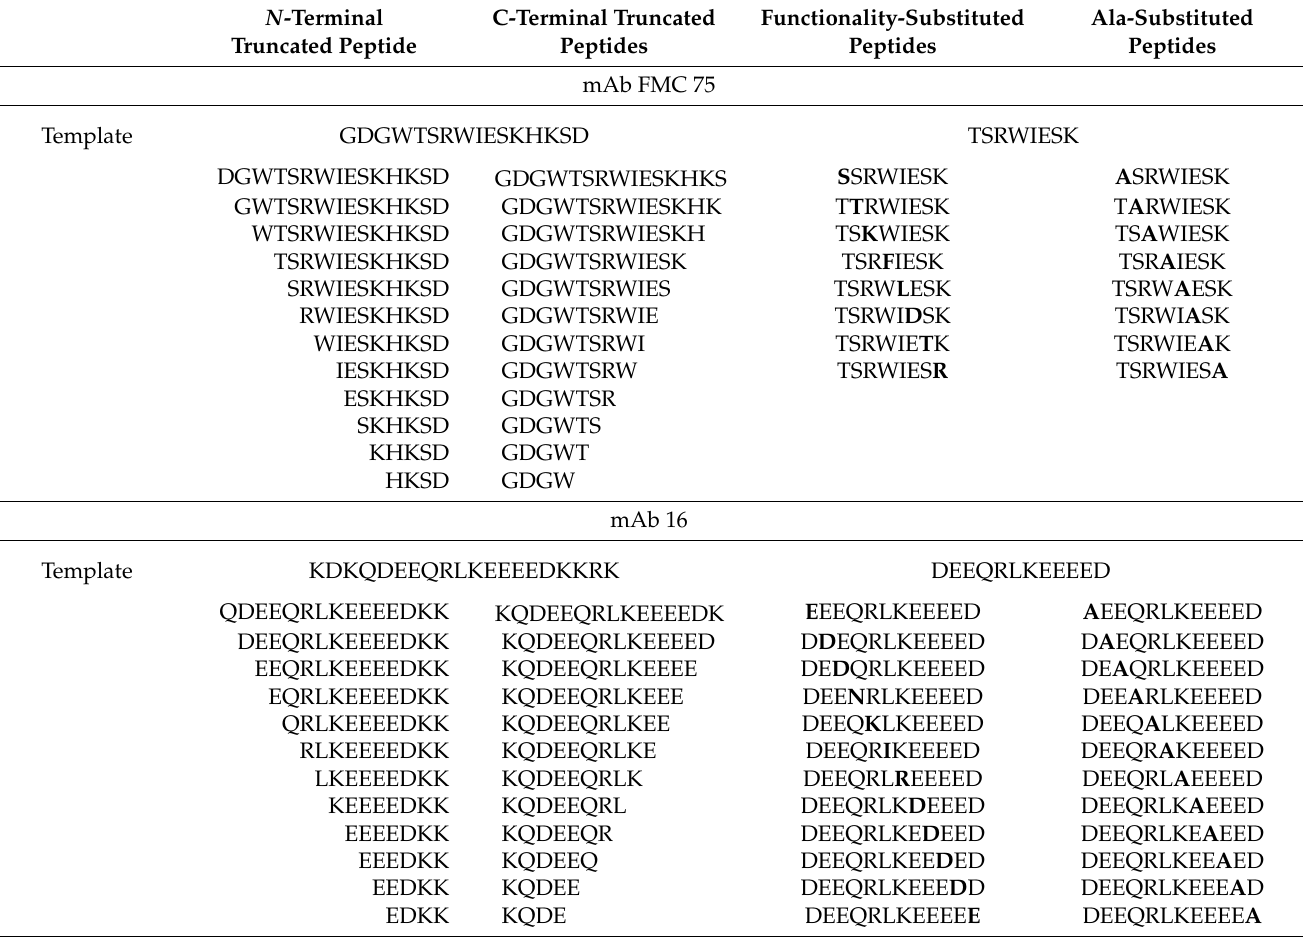
Table 1. Overview of peptides used for antibody